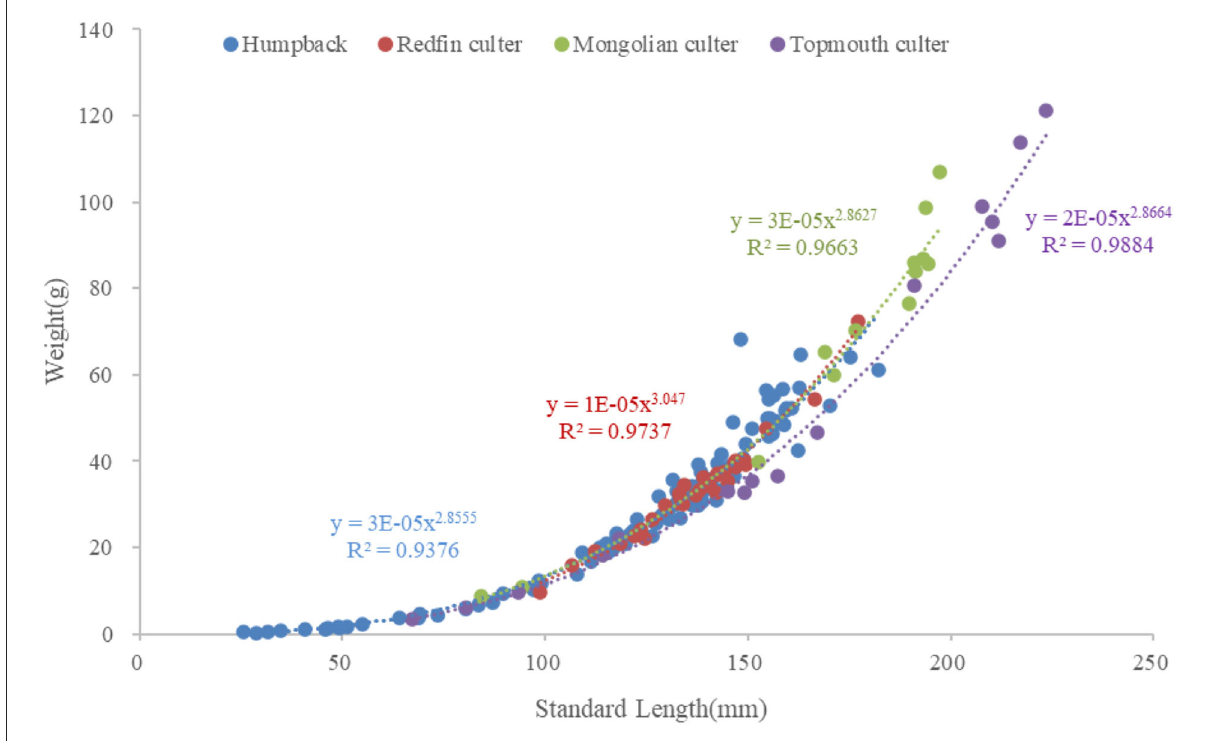
FIGURE2 Relationships between the weights and standard lengths of humpback, redfin culter, Mongolian culter, and topmouth culter.